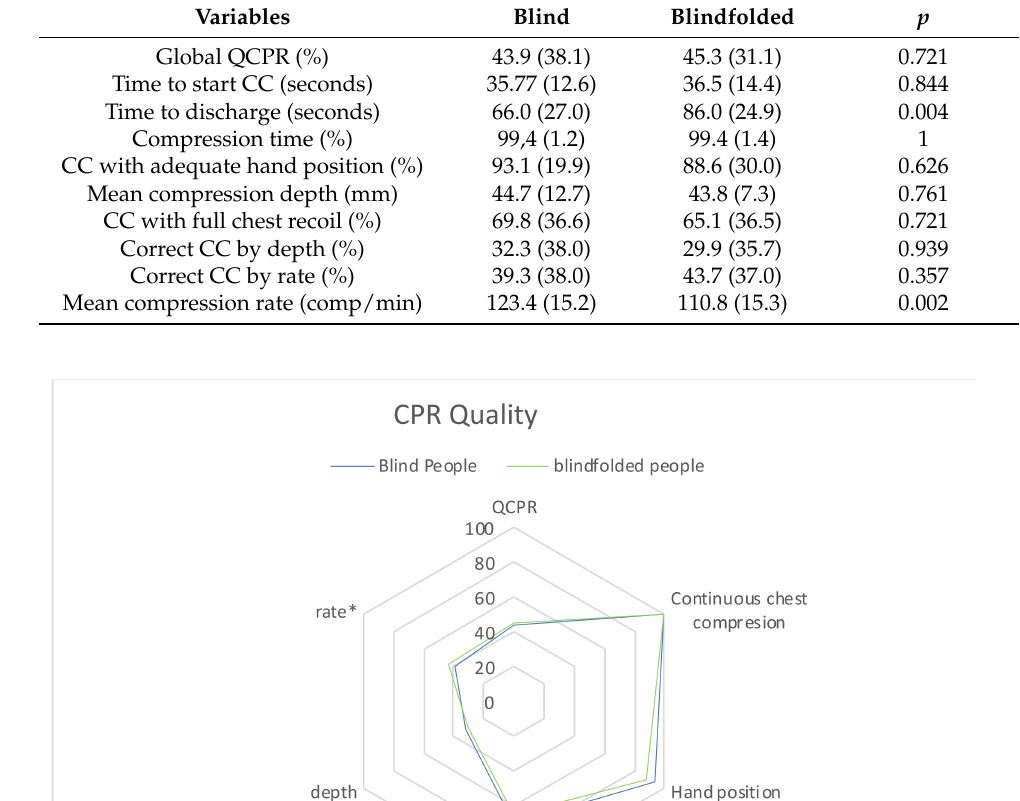
Table 1. Chest compressions quality variables obtained by blind and blindfolded people. Results in mean (standard deviation).